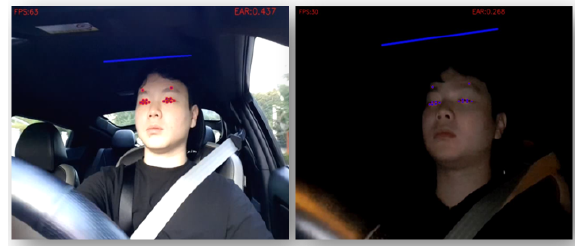
Figure 4. Drowsy driver identification result from the gathered driver behavior video.